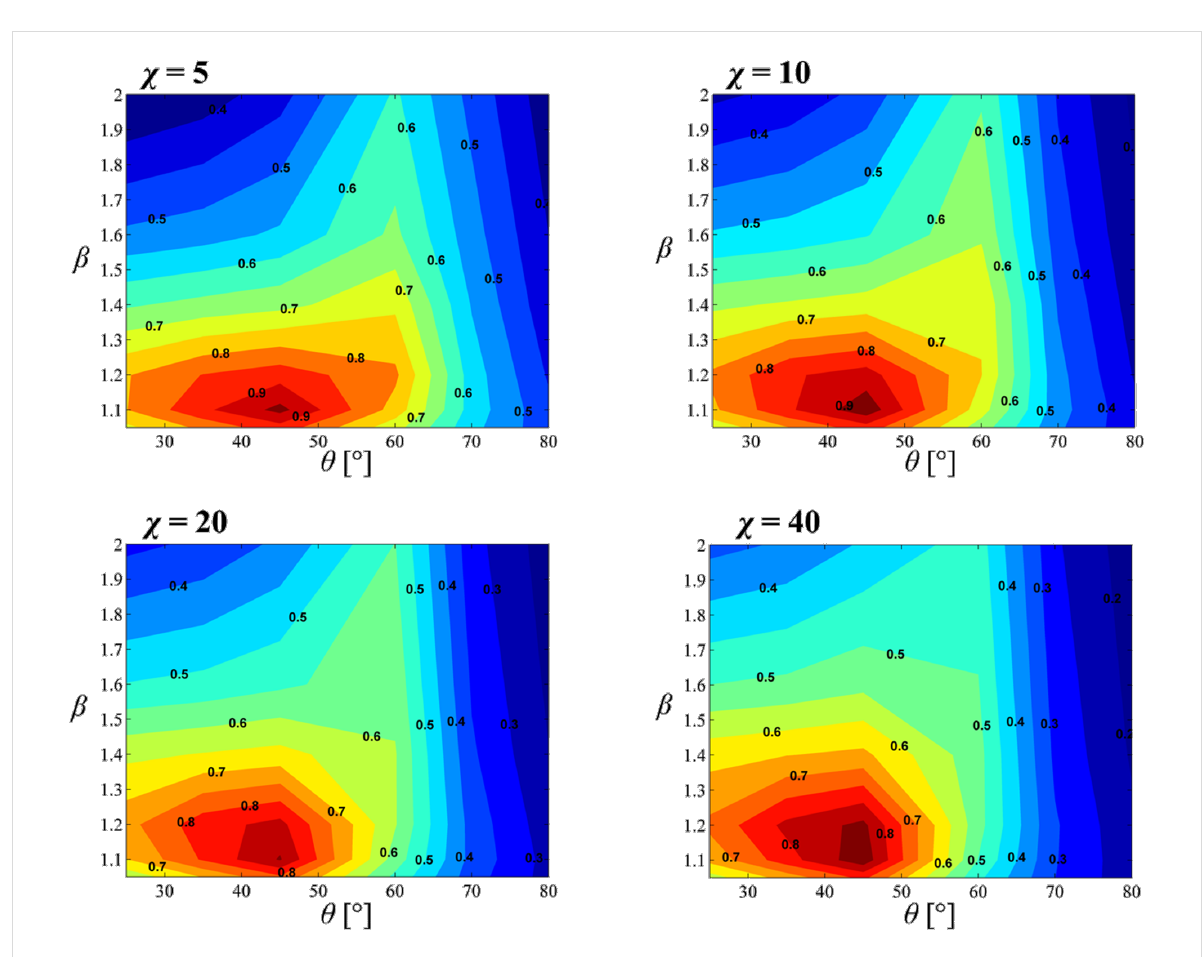
Figure 4: Normalized pull-off stress Φ contour plots for χ = 5 (top left), χ = 10 (top right), χ = 20 (bottom left), and χ = 40 (bottom right) as a function of β and θ . The peak Φ for each case lies within β = 1.1–1.2 and θ =